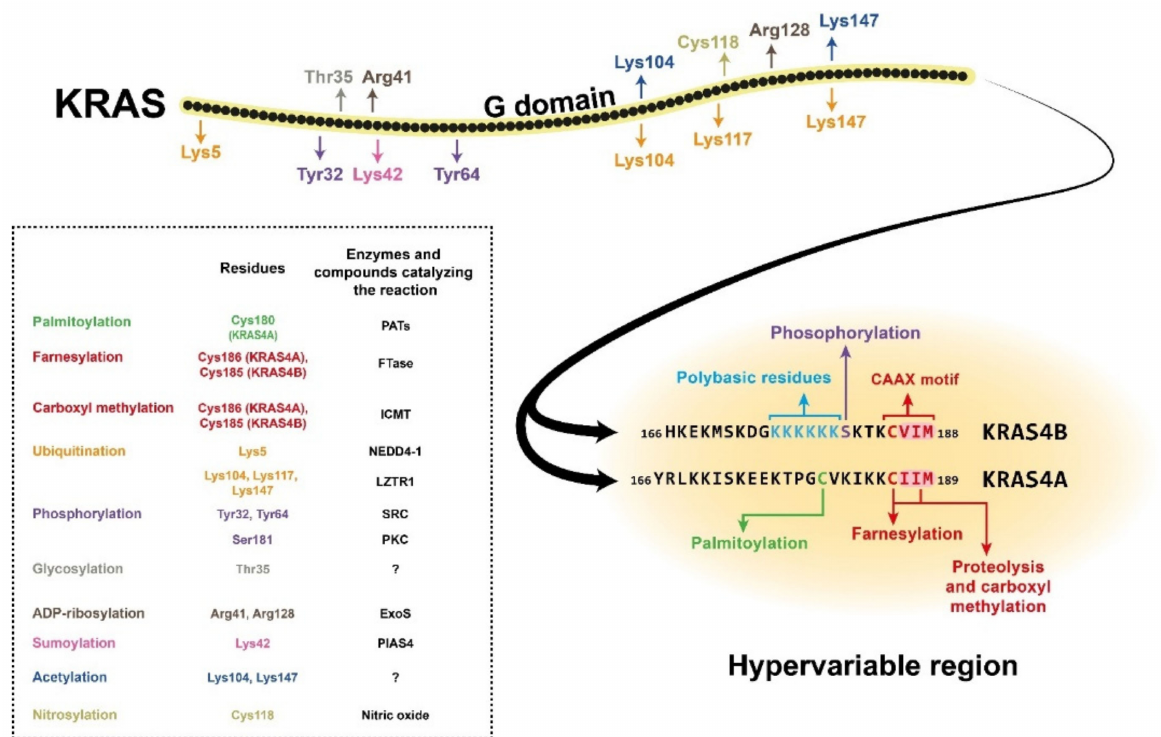
Figure 1. Structure of the KRAS4A and KRAS4B isoforms, showing the amino acid positions of posttranslational modifica- tions with different colours. The hypervariable region sequences are presented separately for the two isoforms due to their high variability. The CAAX motifs and the polybasic residues on KRAS4B are also colour-coded. The posttranslational mod- ifications are listed in the box with the affected amino acid sites and (where known) the enzyme or compound responsible for the reaction. NEDD4-1, neural precursor cell expressed developmentally downregulated 4-1; LZTR1, leucine-zipper-like transcriptional regulator 1; SRC, proto-oncogene tyrosine-protein kinase Src; PKC, protein kinase C; ExoS, exoenzyme S; PIAS4, protein inhibitor of activated STAT protein 4; PATs, protein acetyltransferases; FTase, farnesyltransferase; ICMT, isoprenylcysteine carboxyl